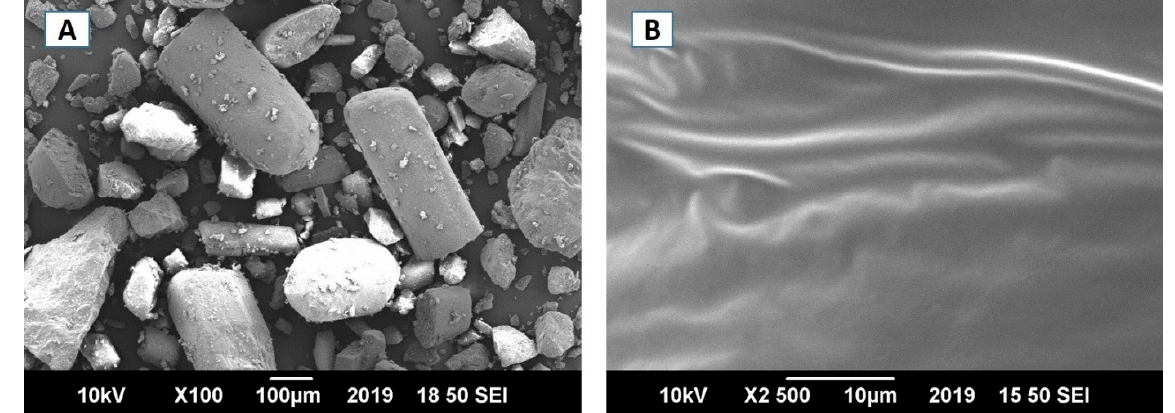
Figure 3. SEM images of ( A ) EBT, ( B ) FC-5 formulation of Orodispersible sublingual film.